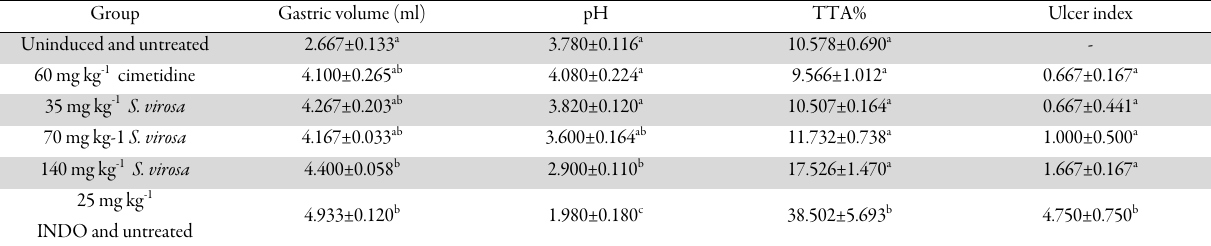
Table 3. Effect of S. virosa leaf extract on gastric volume, gastric pH, total acidity and ulcer index in stomach of rats Group